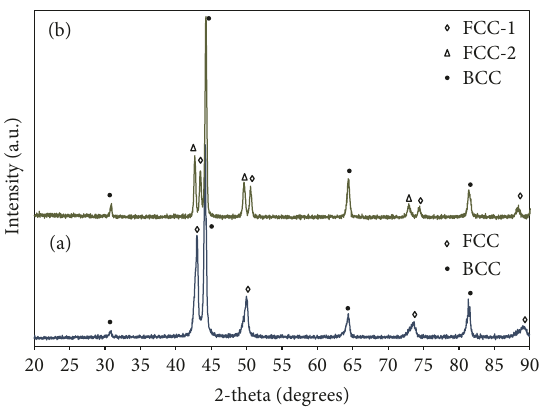
Figure 1: X-ray diffractograms for AlCoCuFeMnNi (a) before heat treatment and (b) after heat treatment.